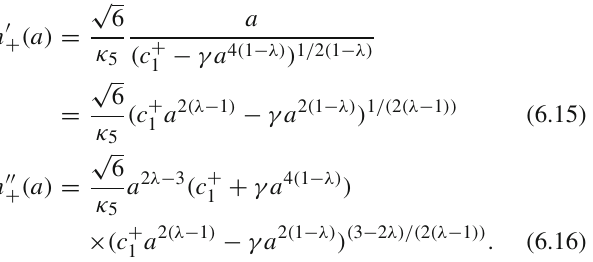
Fig. 5 Graph of the warp factor as a function of Y , for λ = ( 2 k + 1 )/( 2 k